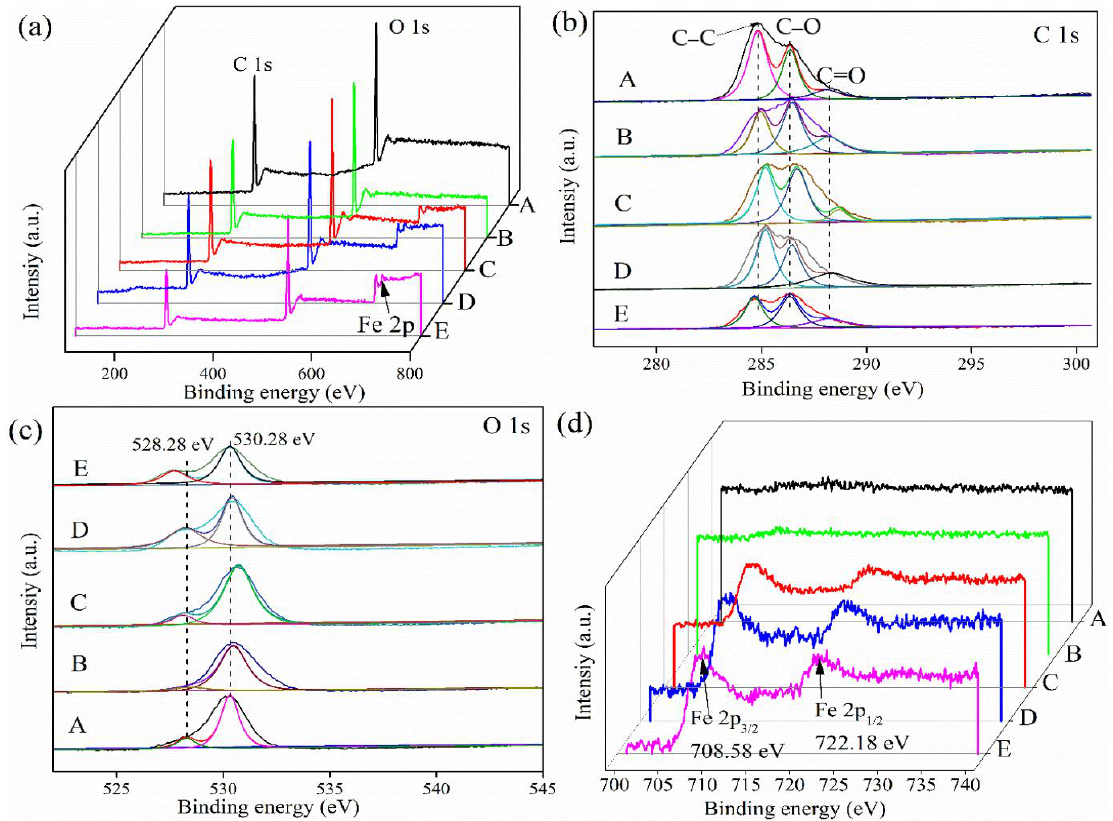
Figure 4. Thermogravimetric (TG) ( a ) and differential thermogravimetric (DTG) ( b ) curves of the fiber and NFF composites under an air atmosphere.